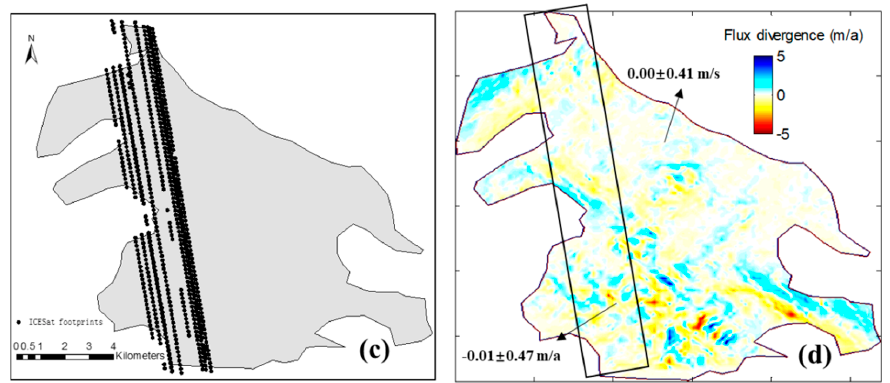
Figure 6. Velocity ( a ), thickness ( b ), ICESat footprints’ coverage area ( c ), and ice flux divergence ( d ) of Guliya